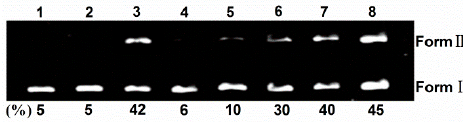
Figure 6. Photocleavage of pBR322 DNA (0.1 μ g) by TCPC (40 μ M) in the presence of additives in Buffer II (pH = 7.2). lane 1, DNA alone; lane 2, DNA + 40 μ M TCPC (dark); lane 3, DNA + 40 μ M TCPC; lane 4, DNA + 40 μ M TCPC + 100 mM NaN 3 ; lane 5, DNA + 40 μ M TCPC + 100 mM DABCO; lane 6, DNA + 40 μ M TCPC +100 mM KI; lane 7, DNA + 40 μ M TCPC + 500 μ M DMSO; lane 8, DNA + 40 μ M TCPC + 500 μ M tert -BuOH.